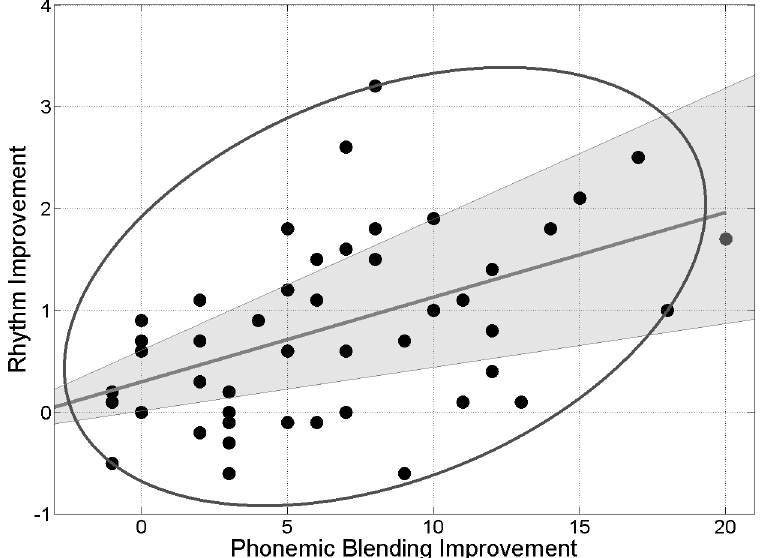
Fig 3. Scatter plot of the improvement in the rhythm reproduction task (accuracy After training — accuracy Before training) and the improvement in the Phonemic blending task (accuracy After training — accuracy Before training). The ellipse contains the non-outlying data. The grey line represents the best linear fit to the remaining data (Spearman skipped correlation, [47]). The shadow represents the 95% bootstrap